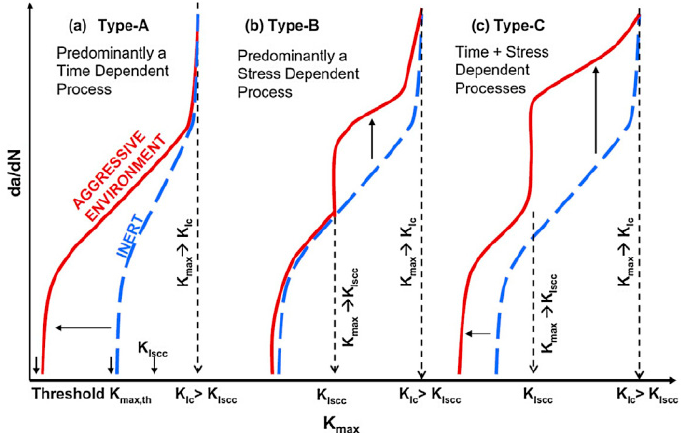
Figure 5. Schematic representation of crack growth under different scenarios of simultaneous cyclic and tensile loading in inert and corrosive environment (according to [75]).